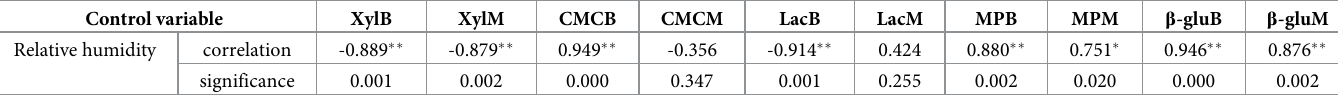
Table 3. The result on correlation analysis of humidity and five